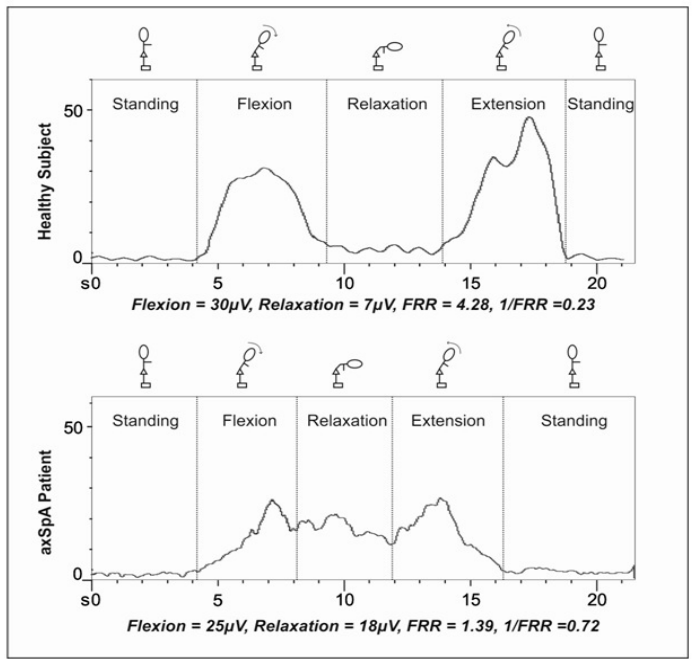
Figure 2. sEMG activity and results obtained by a healthy subject and an axSpA